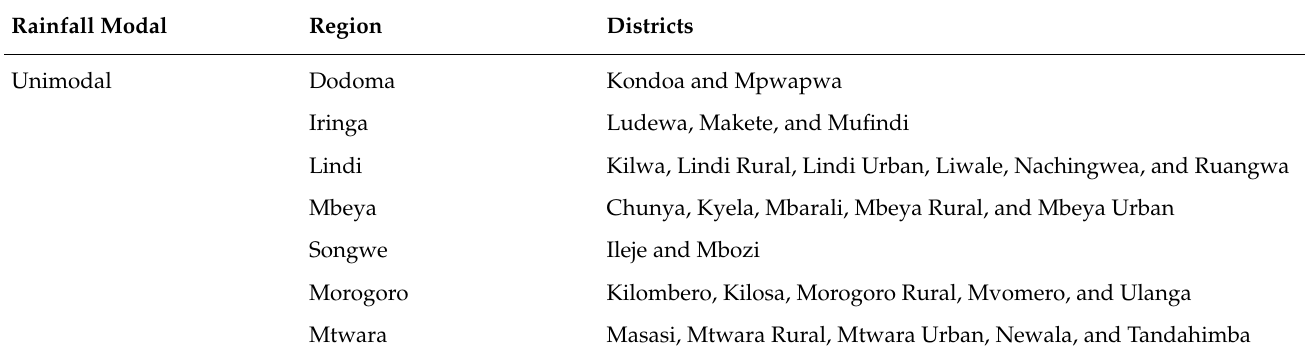
Figure 4. Map of Tanzania in Africa ( left ) and map of Tanzania districts ( right ). Table 1. Tanzania districts whose data were used to train and test deep learning